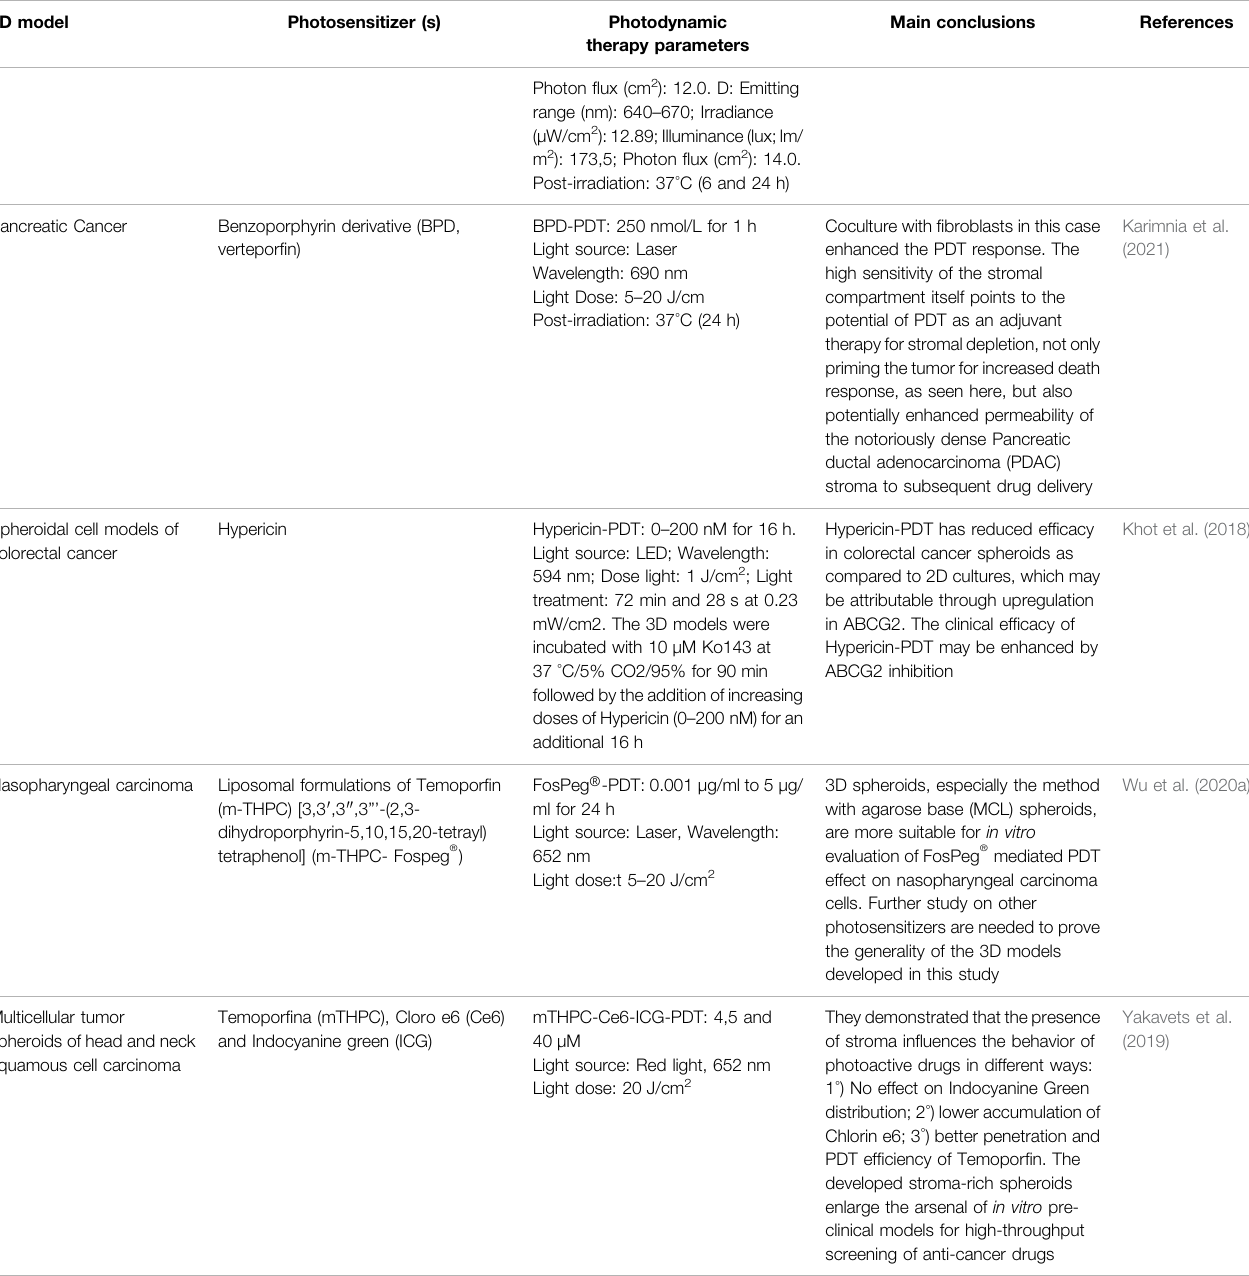
TABLE 3 | ( Continued ) Overview of studies involving 3D tissue engineering model for application in Photodynamic